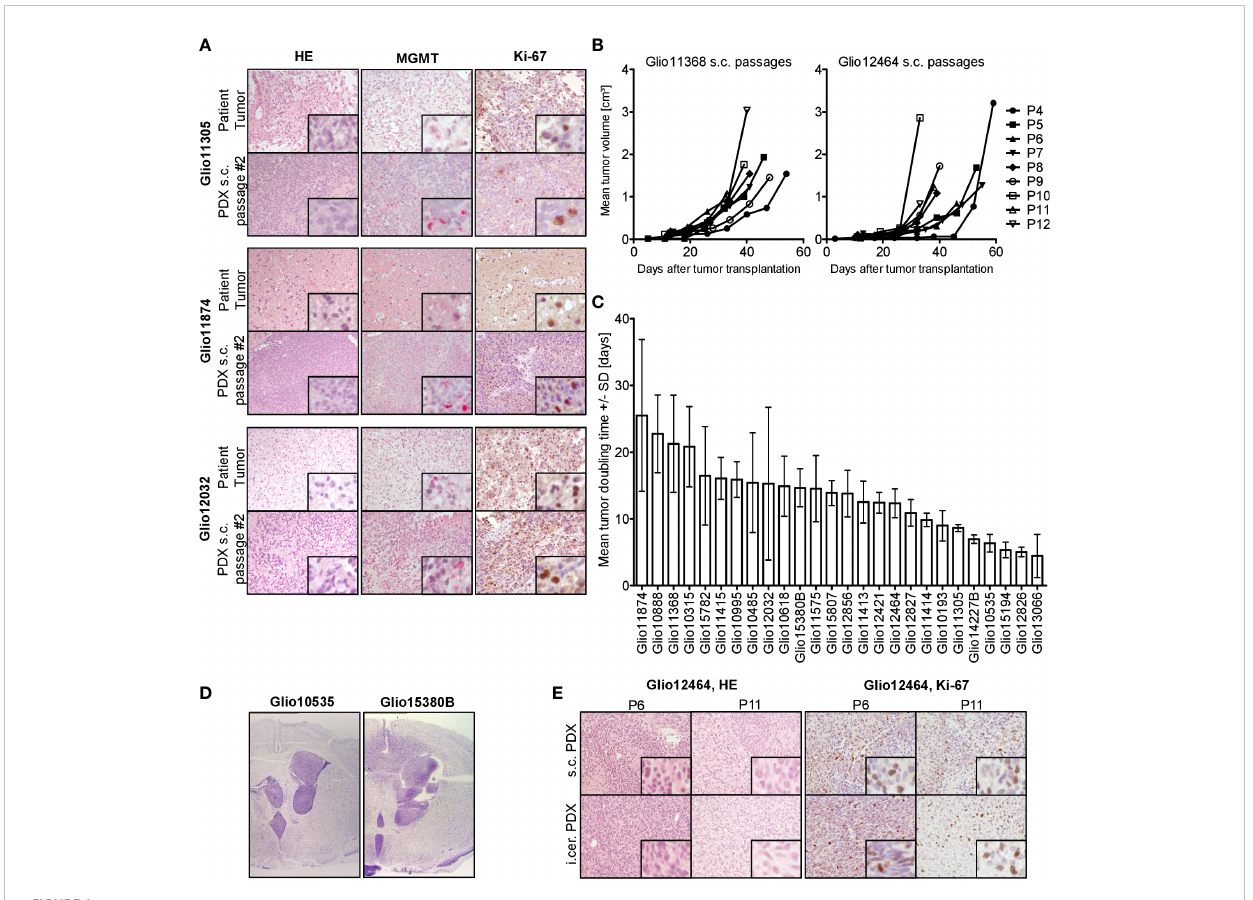
FIGURE 1 Histological and biological characteristics of GBM PDX. (A) Analysis of three representative patient tissue samples and respective s.c. PDX tissue from in vivo passage #2 revealed comparable histology (HE), MGMT expression (red staining) and expression of proliferation marker Ki-67 (brown staining), 200-fold magni fi cation, inset 800-fold magni fi cation. (B) Comparable growth over several consecutive s.c. passages of PDX models Glio11368 and Glio12464. (C) Heterogeneous tumor doubling times in our panel of established PDX models, n=3-6. Mean and standard deviation (SD). (D) Comparison of nodular and in fi ltrative growth in two different orthotopic (intracerebral, i.cer.) PDX models (cresyl violet staining, tumor tissue stained purple) (0.9-fold magni fi cation). (E) Analysis of PDX Glio12464 revealed comparable histology and Ki-67 expression over several consecutive s.c. passages and parallel orthotopic inoculation. Examination of Ki-67 expression (proliferation marker) in PDX tumor tissue via IHC. Positive areas in the sections are stained brown. 20-fold magni fi cation, inset 160-fold magni fi